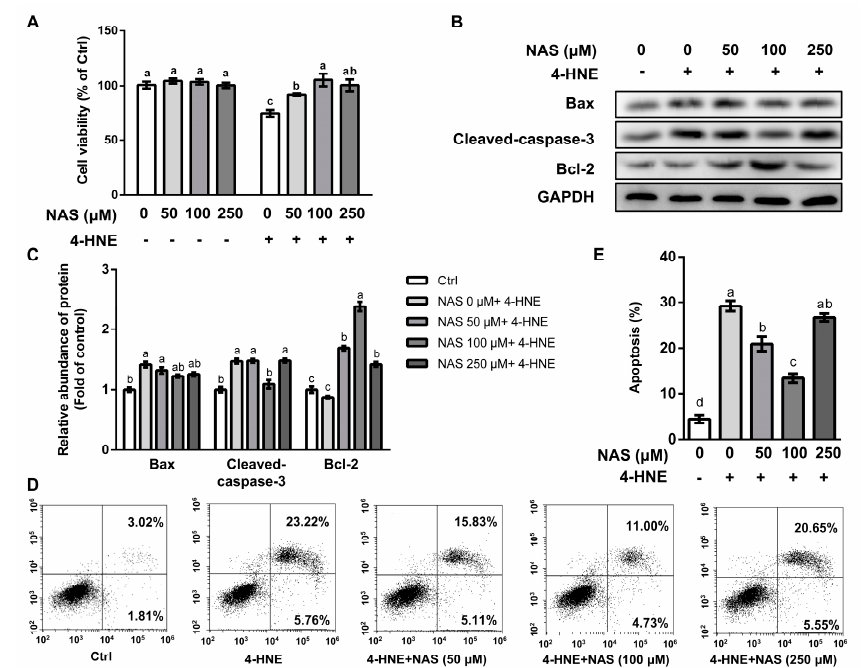
Figure 1. N-acetyl serotonin (NAS) attenuated the 4-HNE-induced apoptosis of IPEC-1 cells. IPEC-1 cells pre-treated with NAS (0- 250 µ M, 12 h) were treated with or without 4-HNE (20 µ M) for 2 h. Cell viability ( A ), the protein abundances of Bax, cleaved caspase-3, Bcl-2, and GAPDH ( B ), protein band density ( C ), apoptosis ( D ), and its statistical analysis ( E ) are shown. Representative results from three independent experiments were provided, and values are means ± SEMs, n = 3. Means without a common letter di ff er, p <